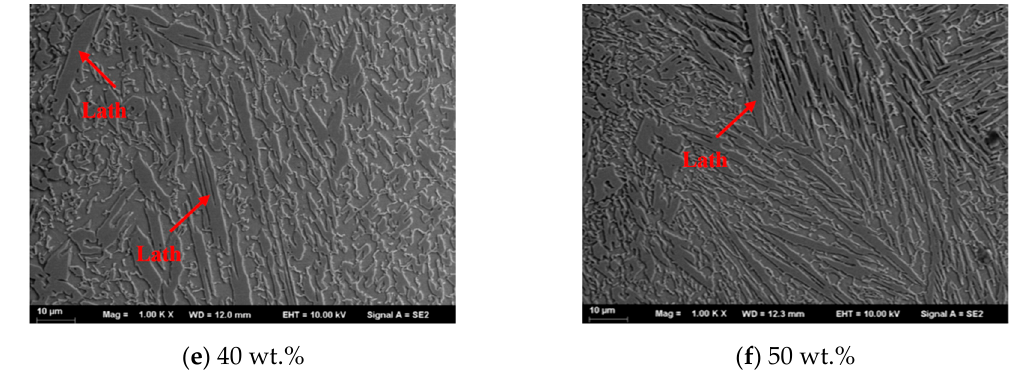
Figure 3. Microstructure of the laser cladded Ni45 + high-carbon ferrochrome coatings.